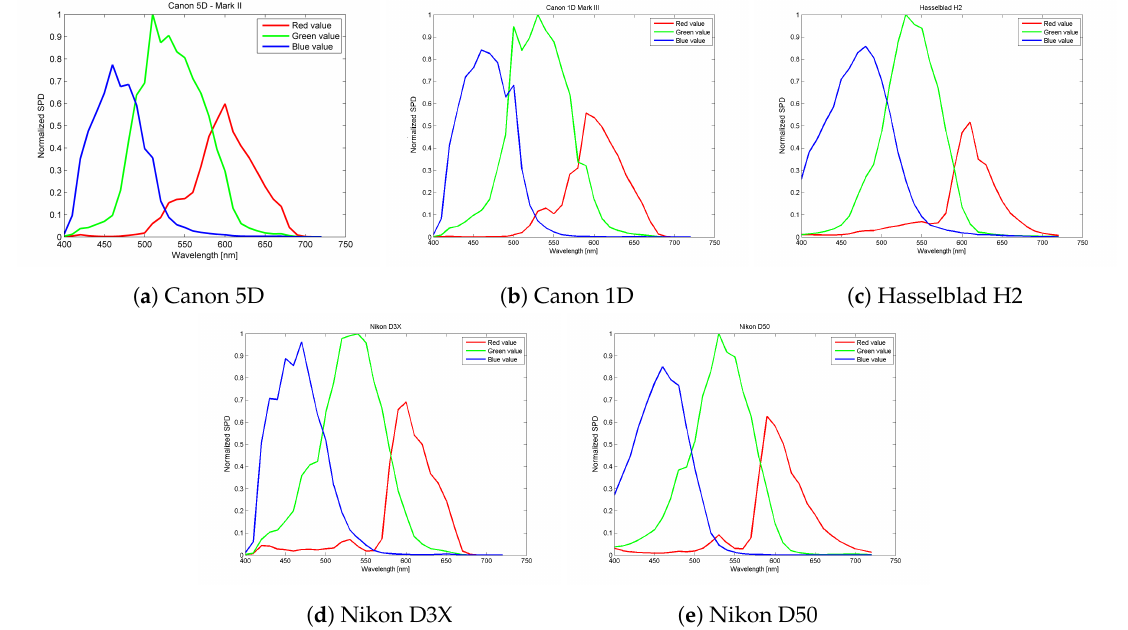
Figure 4. Spectral sensitivity functions for 5 digital cameras.